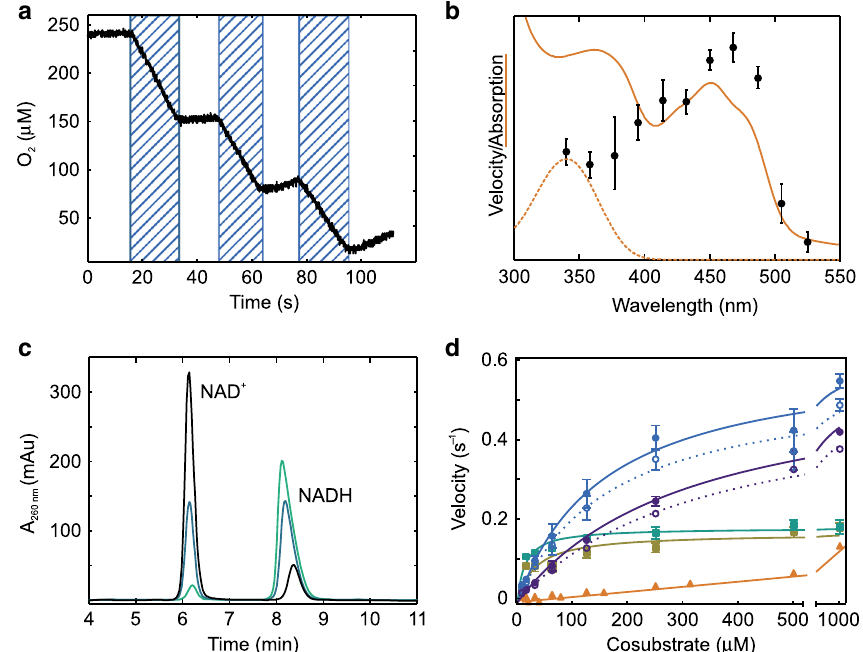
Fig. 2 Characteristics of PqsL photoreactivity. a PqsL photoreduction measured over several cycles of illumination (shaded intervals). The reaction of 10 µ M PqsL was monitored by O 2 consumption, 1.25 mM NADPH was used as electron donor (one representative experiment shown). b Apparent velocity as a function of the wavelength of the illuminating light (black dots) together with the UV/Vis spectra of PqsL (orange, solid line) and NADH (orange, dashed line). c NAD + formation from NADH oxidation by PqsL after 1 min (light green), 5 min (petrol blue) and 10 min (black) of illumination, as monitored by HPLC (one representative experiment). d Kinetics of light-induced oxygen consumption by PqsL supplemented with NADPH (blue circles), NADH (violet circles), NADPH + 2-ABA (green squares) and NADH + 2-ABA (ocher squares) or free FAD + NADPH (orange triangles). Rates of the PqsL reactions were corrected for the contribution of residual free FAD (calculated from K D of the PqsL – FAD complex) and FAD photodegradation. Dashed lines/open circles show the rates of FAD-saturated PqsL prior to any corrections (i.e. rates as measured, normalized to FAD content). Line fi ts were calculated according to a Michaelis-Menten model. Parameters are provided in Supplementary Table 1. Experimental data on photoreduction of PqsL and free FAD with various alternative electron donors are provided in Supplementary Figs. 2 and 3. Error bars indicate SD of three identical measurements (panels b , d ).